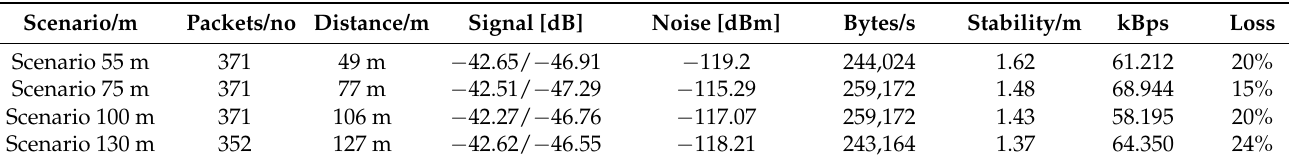
Table 5. Simulation scenarios at a distance of 130 m from reception, data interpretation, losses, data transfer, signal, and